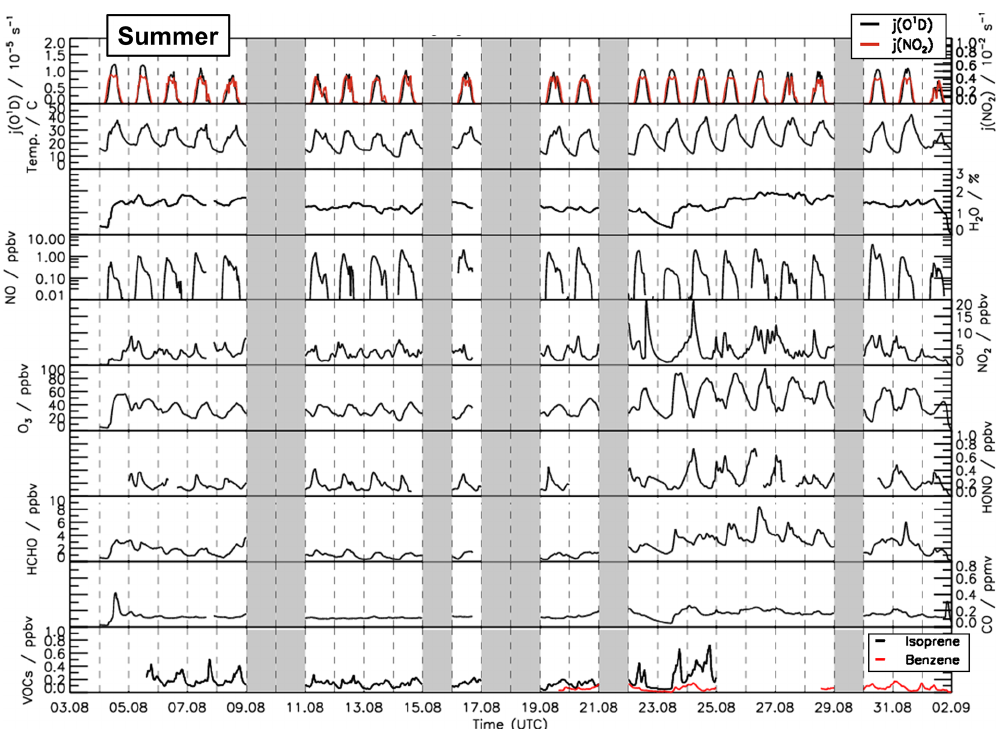
Figure 2. Time series of temperature and trace gas concentrations during the summer period of the JULIAC campaign. Vertical dashed lines denote midnight. Grey shaded areas indicate calibration days when no measurements were done and days when the chamber roof was closed due to bad weather